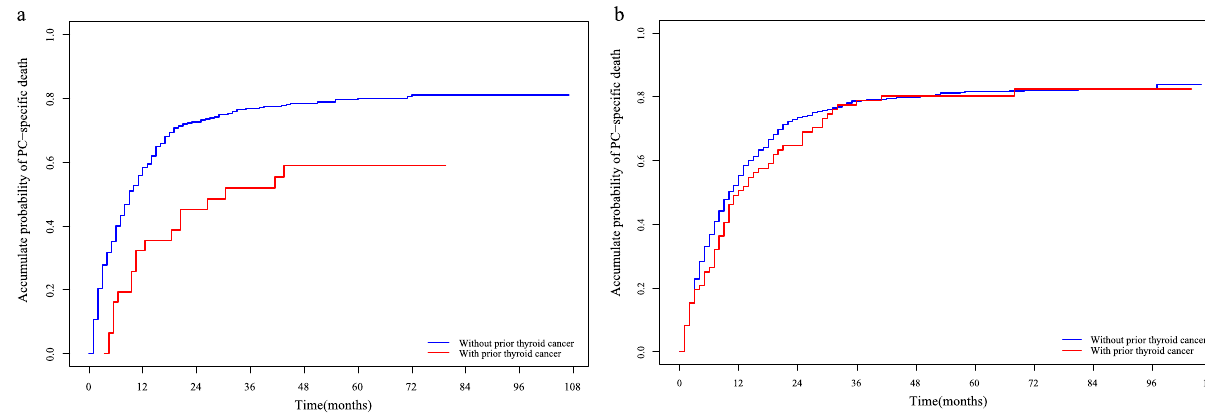
Figure 4. Cumulative incidence of PC-specific death between female and male PC patients with and without prior thyroid cancer. ( a ) Males. ( b ) Females. PC pancreatic cancer. Subgroup